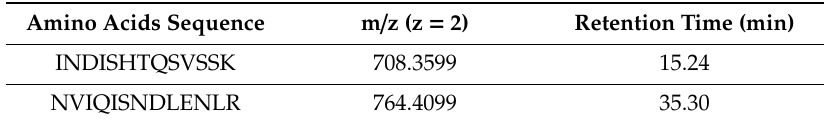
Table 1. Amino acids sequence, m / z ratio and retention time of selected peptides from human leptin (UniProt KB code P41159, Homo sapiens